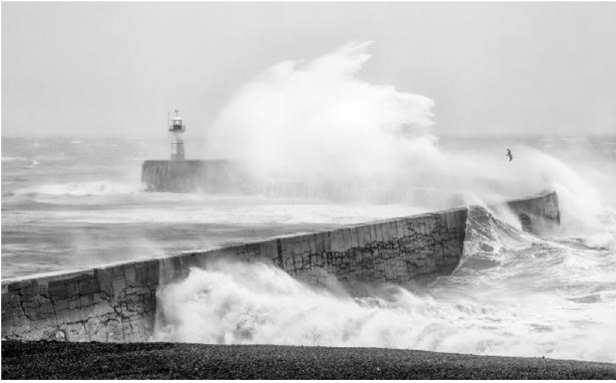
Fig. 2. Storm Ciara, February 2020, UK.